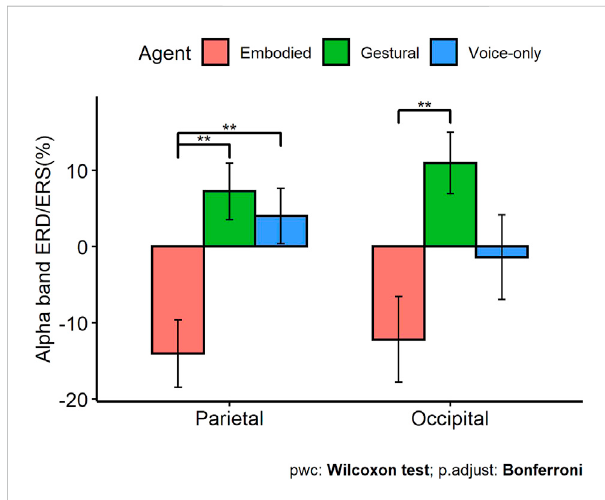
FIGURE 5 Alpha band ERD/ERS (Error bars represent the standard error of the mean; Statistical signi fi cance: ** (p <